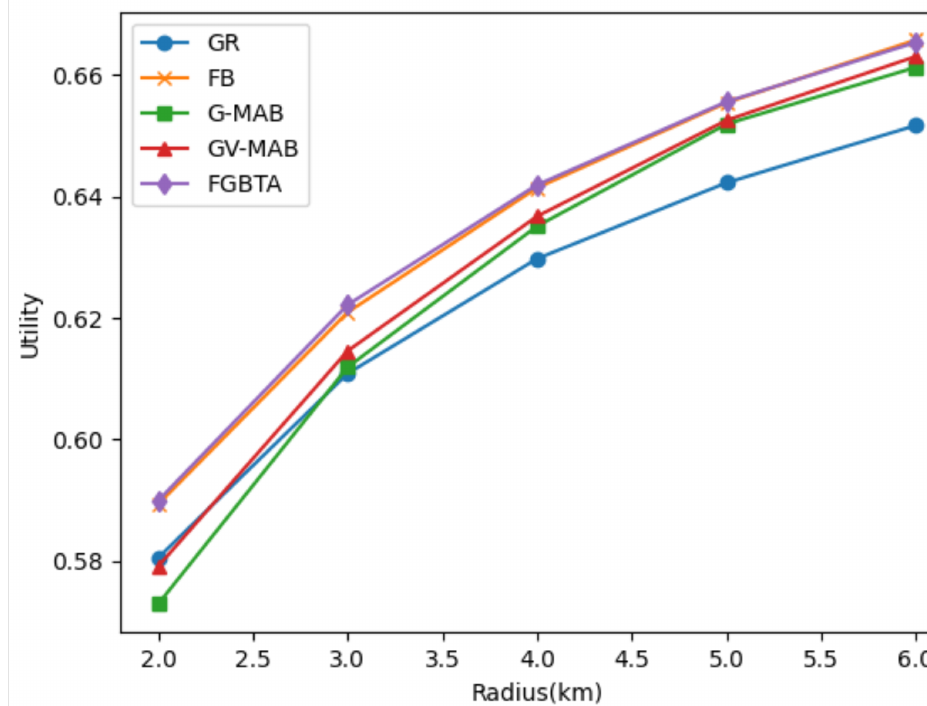
Figure 6. Utility of varying radius.